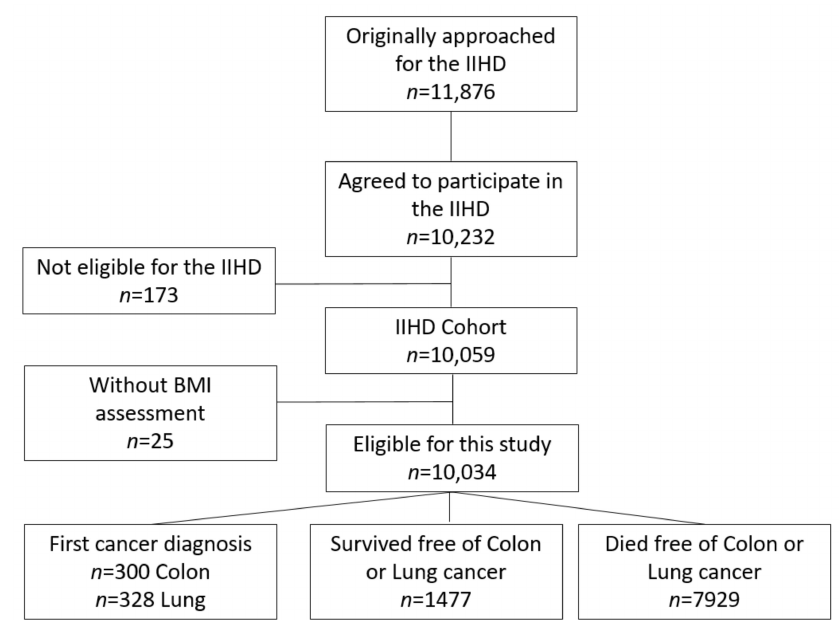
Figure 1. Flow chart of patients’ inclusion into the